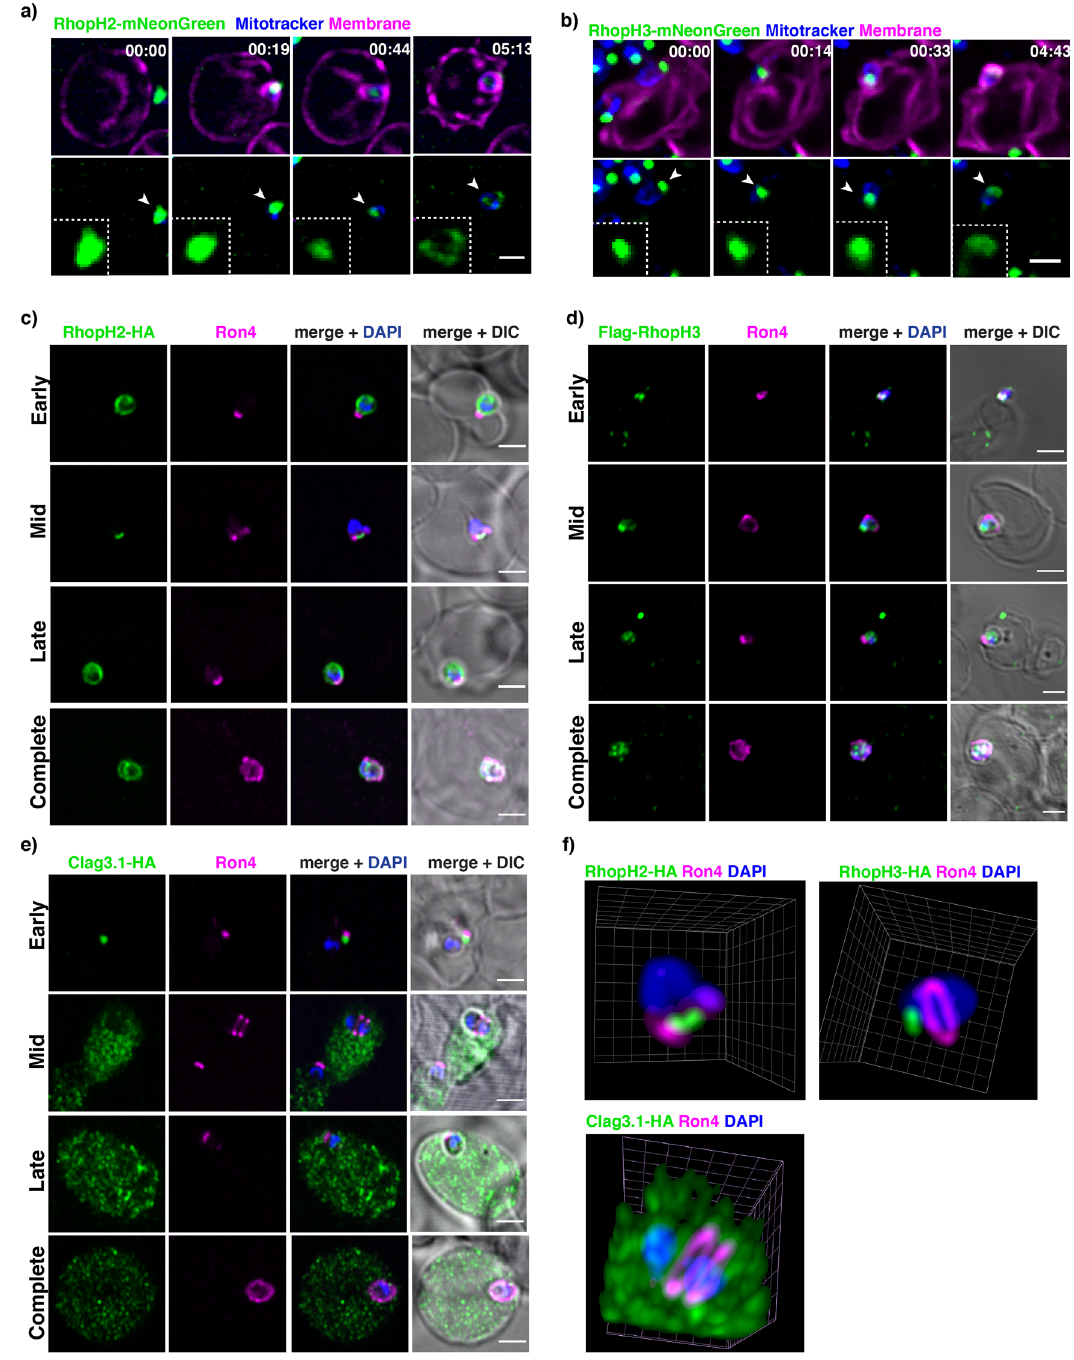
Fig. 2 Subcellular localisation of RhopH proteins during parasite invasion. a Live RhopH2-mNeonGreen merozoites invading human erythrocytes imaged using lattice-light sheet microscopy. mNeonGreen signal (white arrows) visible as a bright spot on the merozoite apical end corresponding to RhopH2. The signal became diffused upon successful invasion as the parasitophorous vacuole formed. b Live RhopH3-mNeonGreen merozoites invading human erythrocytes imaged using lattice-light sheet microscopy. mNeonGreen signal (white arrows) visible as a bright spot on the merozoite apical end corresponding to RhopH3. The signal became diffused upon successful invasion as the parasitophorous vacuole formed. c Localisation of RhopH2-HA and RON4 in fi xed merozoites at early, mid, late and complete stages of erythrocyte invasion. RON4 was a marker for the tight junction to assess the stage of invasion. Scale bar 2 µ m. d Flag-RhopH3 and RON4 in fi xed merozoites at early, mid, late and complete stages of erythrocyte invasion. RON4 was a marker for the tight junction to assess the stage of invasion. Scale bar 2 µ m. e Clag3.1-HA and RON4 in fi xed merozoites at early, mid, late and complete stages of erythrocyte invasion. RON4 was a marker for the tight junction to assess the stage of invasion. Scale bar 2 µ m. f Super-resolution 3D reconstructions of invading merozoites. RON4 labelled in magenta marks the tight junction. HA-tagged Clag3.1, RhopH2, or RhopH3 are labelled in green. Clag3.1 signal appears in the host cytoplasm while RhopH2 and RhopH3 remain concentrated at the apical end of the invading